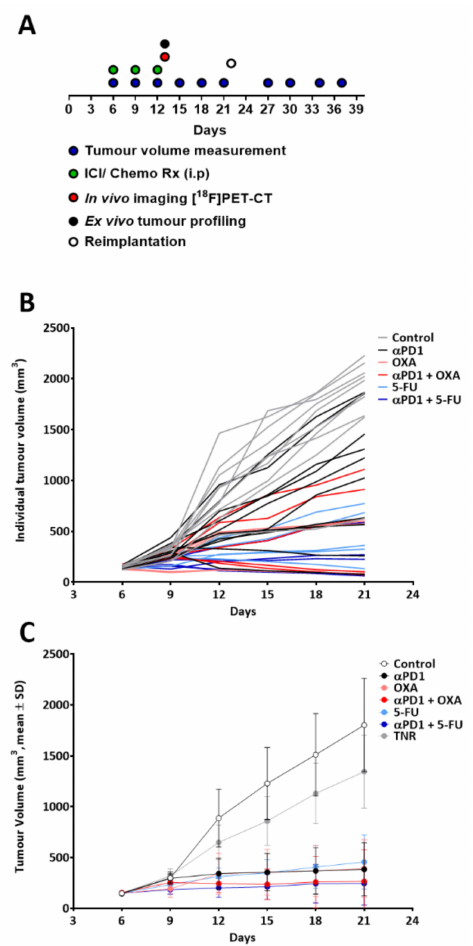
Figure 1. ( A ) Schema representing the dosing, measurement and imaging procedure. Mice ( n = 10 per treatment arm) were treated with control IgG, α PD1, oxaliplatin (OXA), combination α PD1 + OXA, 5-fluorouracil (5-FU) or combination α PD1 + 5-FU post-tumour implantation. ( B ) Individual animal tumour volumes showing heterogeneity in tumour response. ( C ) Average tumour volume in each treatment arm, post-therapy response stratification. Data are displayed as means ± S.D. TNR, treated